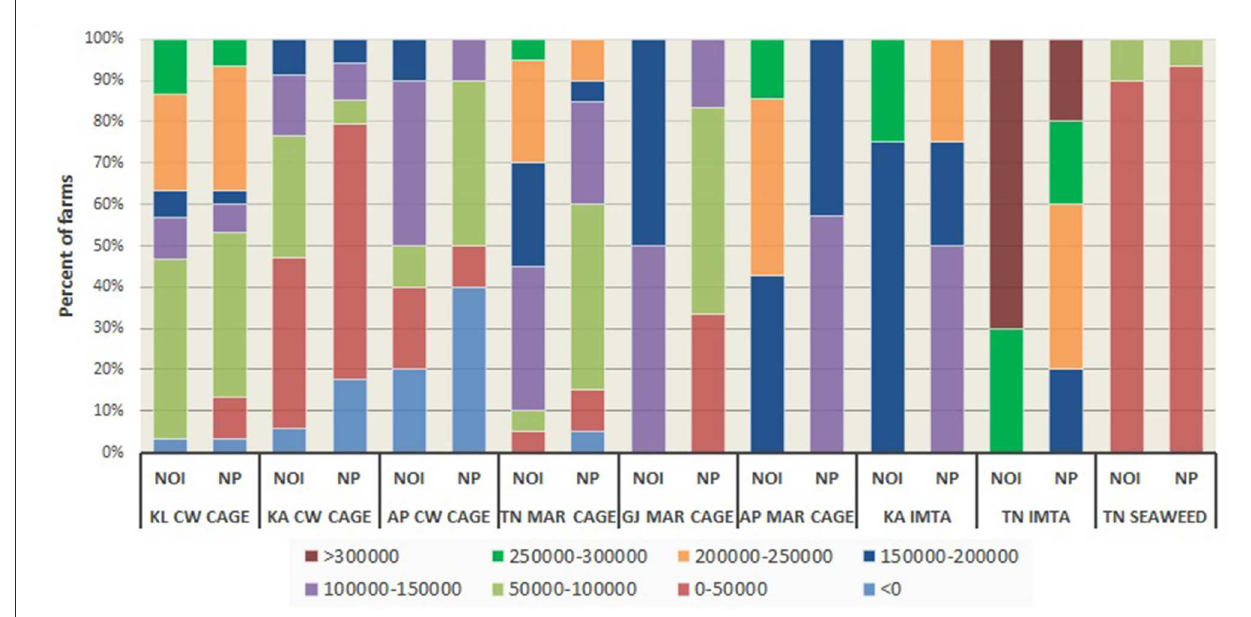
FIGURE3 Distribution of net operating income (NIO) and net profit (NP) of sample farms. For seaweeds, income estimates are reported for a batch of 10 rafts each for the sample farmers. Profitability is expressed in Indian rupees [1 Indian Rupee (INR) = 0.012 US Dollars]. KL CW CAGE: Coastal water cage, Kerala; KA CW CAGE: Coastal water cage, Karnataka; AP CW CAGE: Coastal water cage, Andhra Pradesh; TN MAR CAGE: Marine cage, Tamil Nadu; GJ MAR CAGE: Marine cage, Gujarat; AP MAR CAGE: Marine cage, Andhra Pradesh; KA IMTA: IMTA, Karnataka; TN IMTA: IMTA, Tamil Nadu; TN SEAWEED: Seaweed, Tamil Nadu.